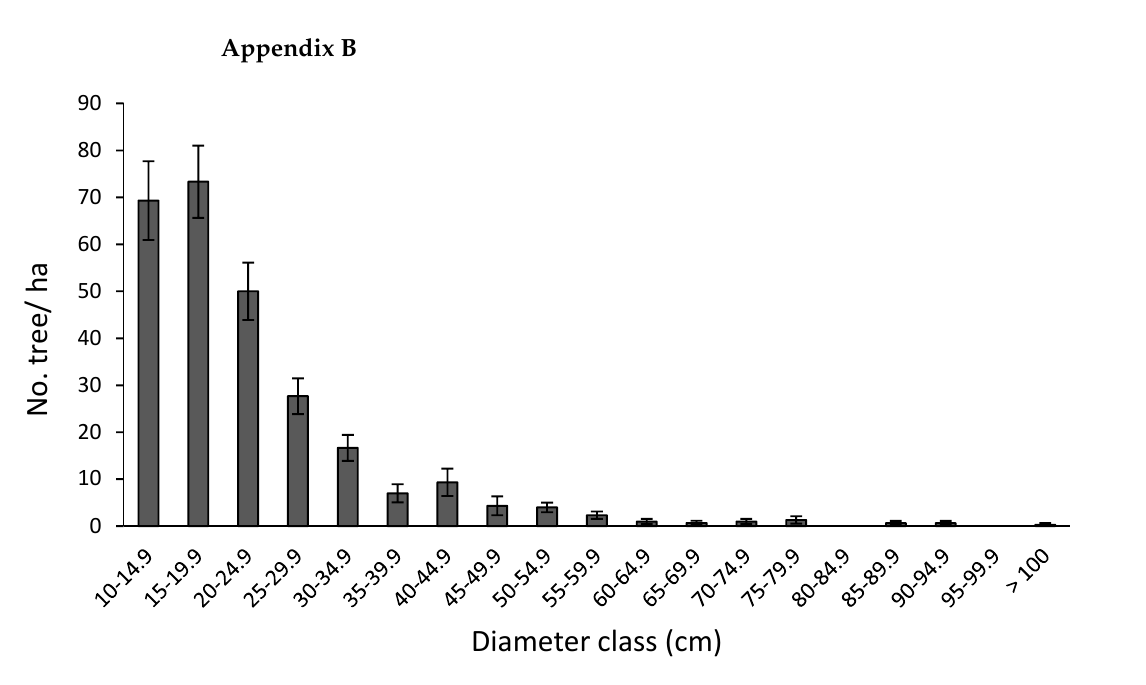
Figure A1. Distribution of trees in categories of diameter at breast height (DBH) in the secondary cloud forest. Trees ≥ 55 cm in DBH correspond to remnant old trees.